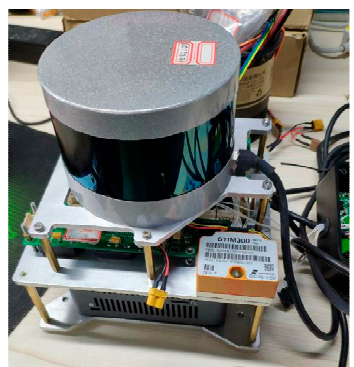
Figure 6. The hand-held SLAM device description: the laser scanner is Velodyne VLP-16 and the IMU is STIM300. The sensors data are processed by an Intel NUC with Intel Core i7-8559U CPU and 16 GB